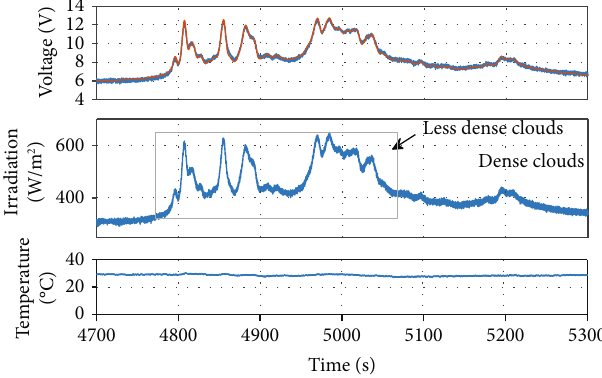
Figure 15: Proposed emulator test under variable irradiation.